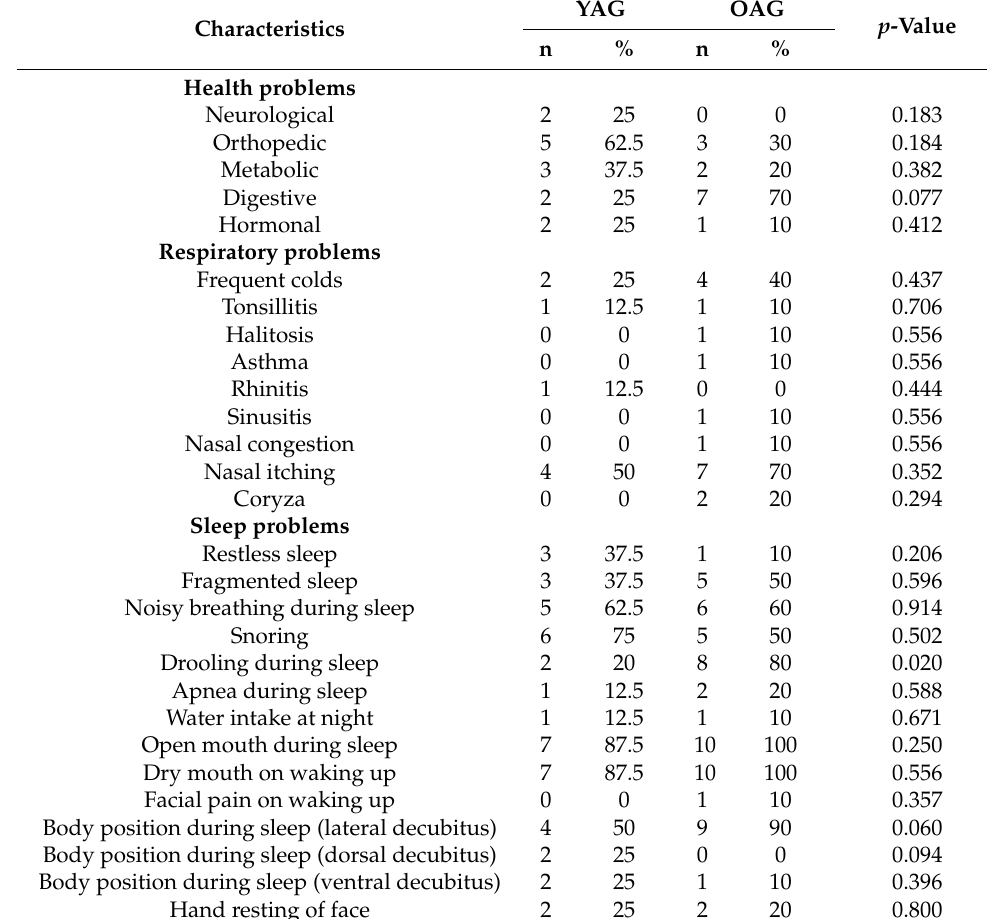
Table 2. Health, respiratory and sleep problems in adults with Down syndrome according to their